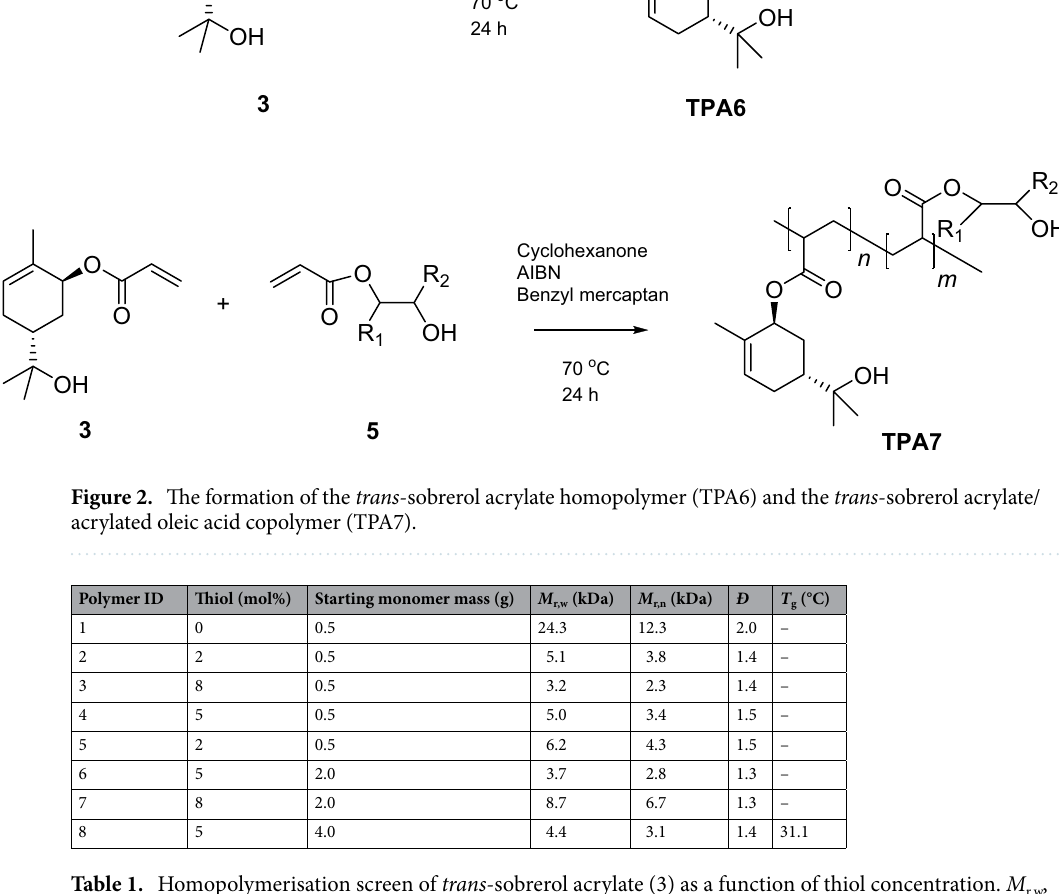
Table 1. Homopolymerisation screen of trans -sobrerol acrylate (3) as a function of thiol concentration. M r,w , M r,n —relative weight and number average molar masses (relative to poly(methyl methacrylate) standards) from gel permeation chromatography, Đ = M r,w / M r,n. T g —glass transition temperature (from DSC).